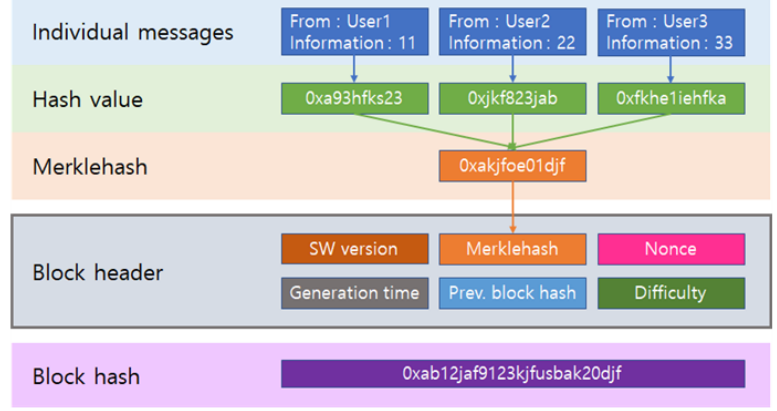
Figure 4. Abstract blockchain structure.